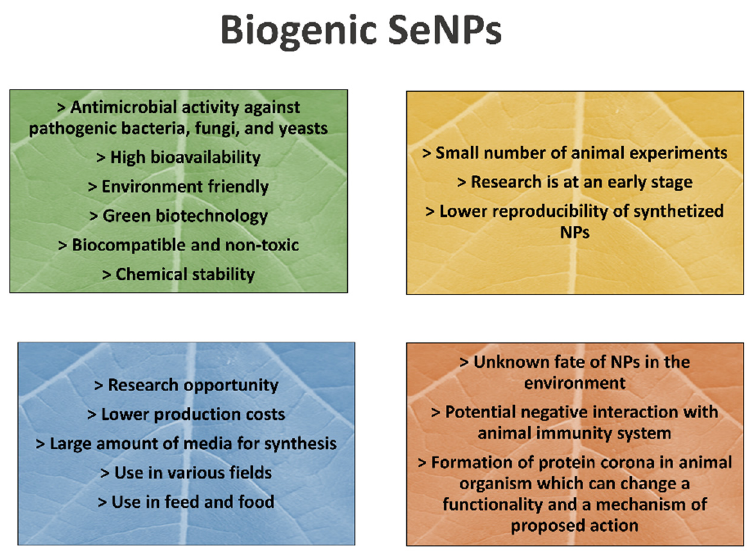
Figure 1. The strengths, weaknesses, opportunities, and threats (SWOT) analysis of SeNP application in animal nutrition.